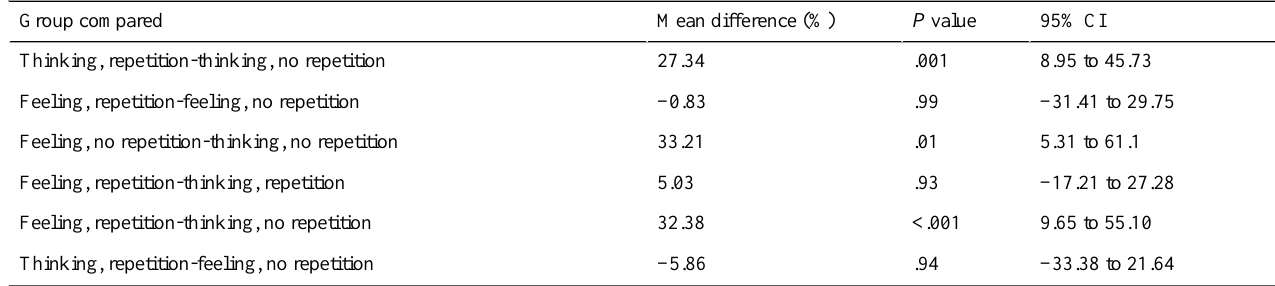
Table 3. Comparison of personality type and repetition groups based on estimated marginal